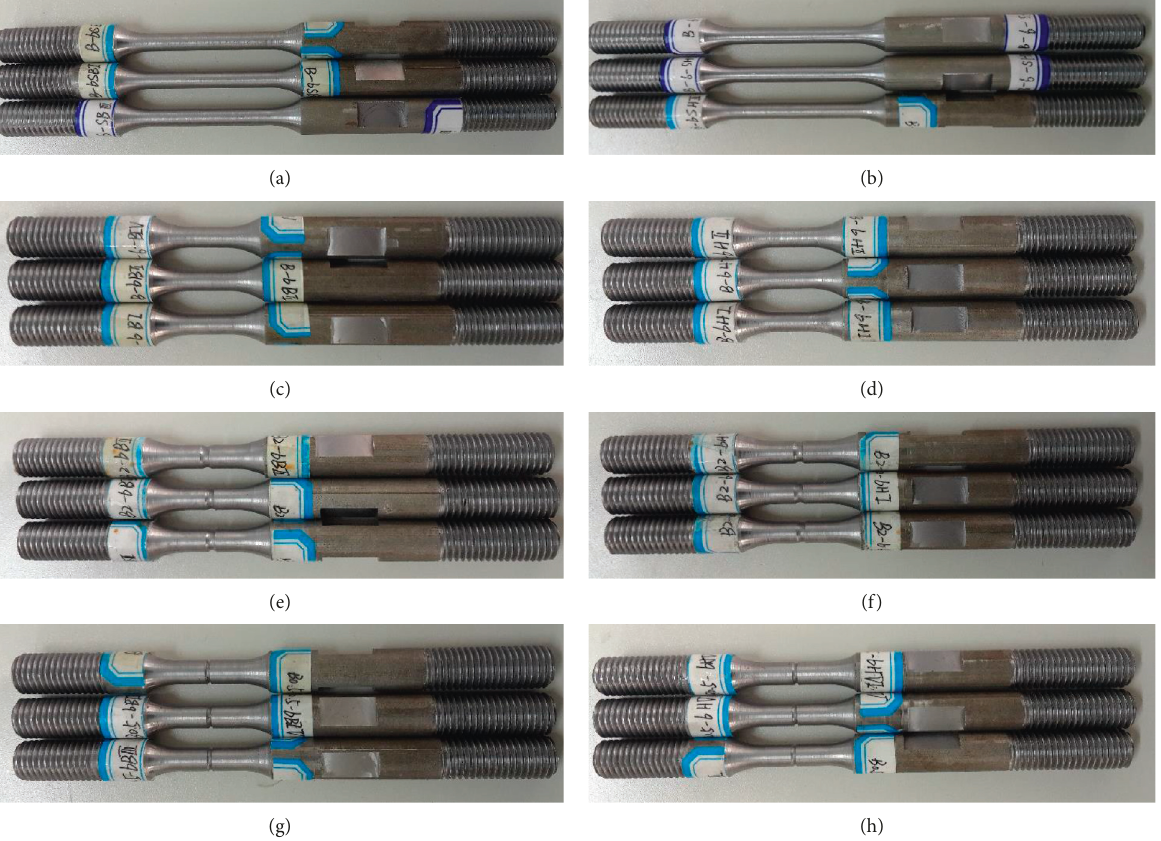
Figure 4: Processing diagram of round bar specimen. (a) B-6-SB. (b) B-6-SH. (c) B-6-B. (d) B-6-H. (e) B2-6-B. (f) B2-6-H. (g) B0.5-6-B. (h)